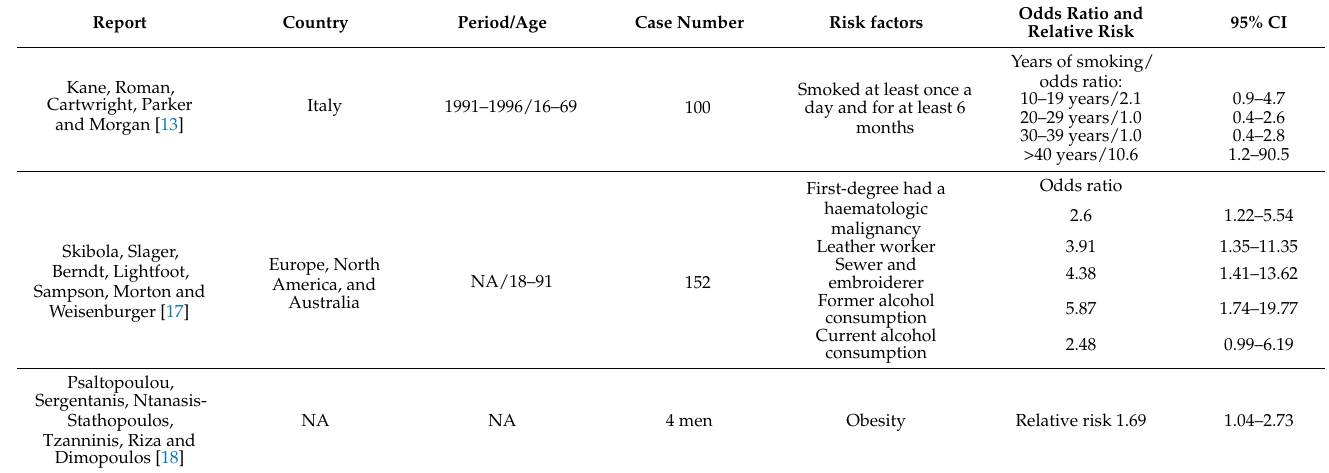
Table 2. Risk factors for ALL in